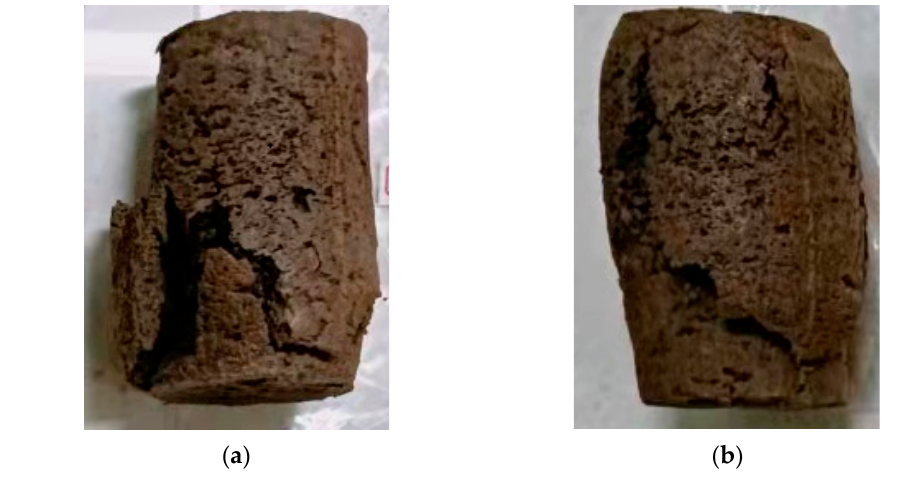
Figure 9. Damage form ⅰ and ⅱ . ( a ) Damage ⅰ, ( b ) Damage ⅱ.